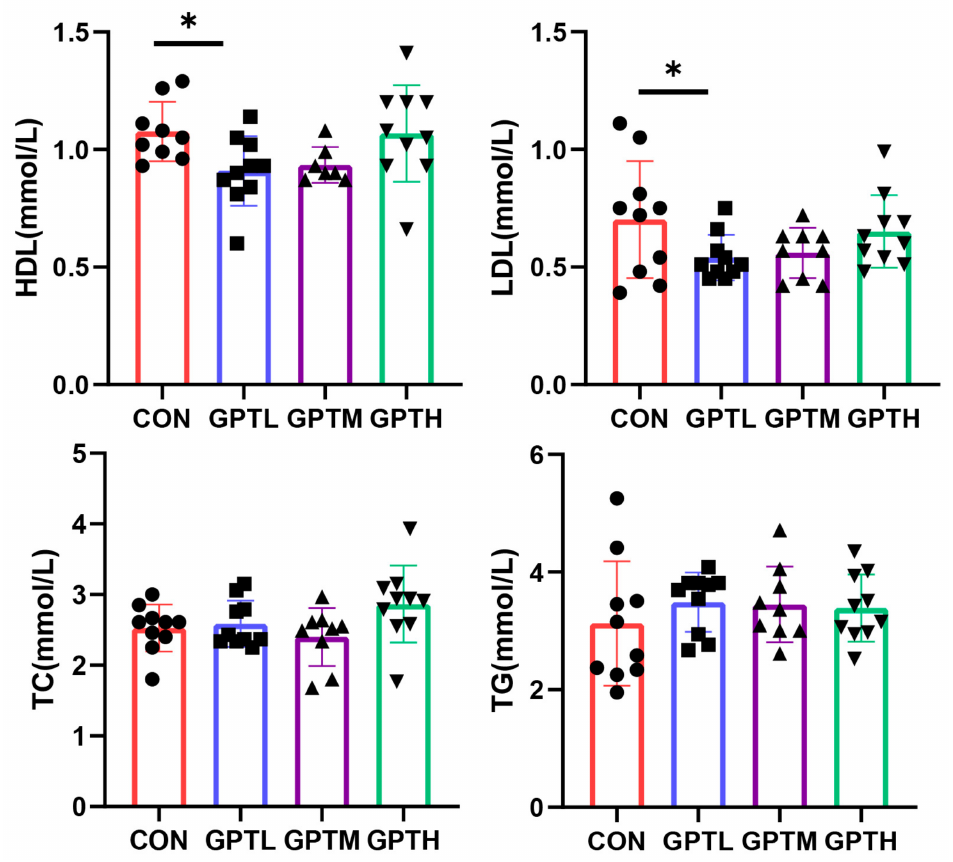
Figure 3. Serum lipid indices (* p <